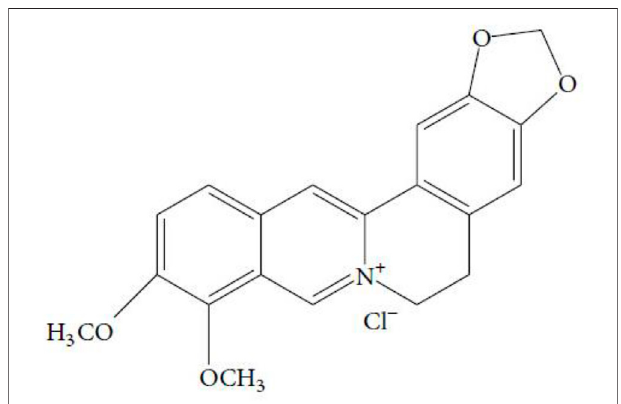
FIGURE 1 | The chemical structure of